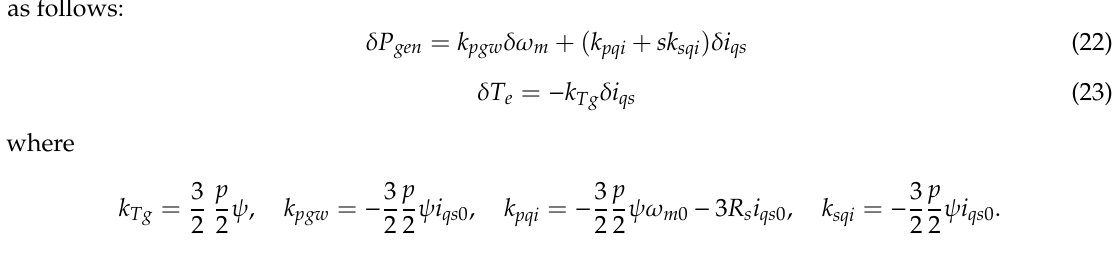
is a negative coefficient. Figure 5